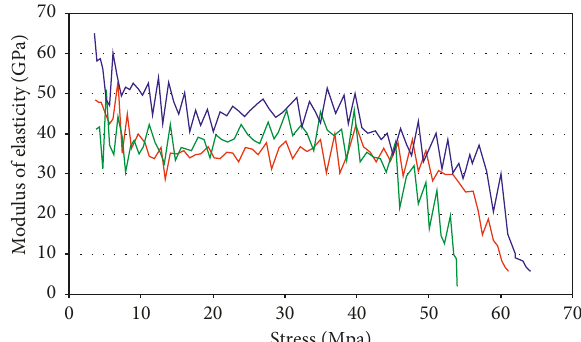
Figure 11: Derivation of the elastic modulus vs. stress of three arbitrarily chosen specimens.